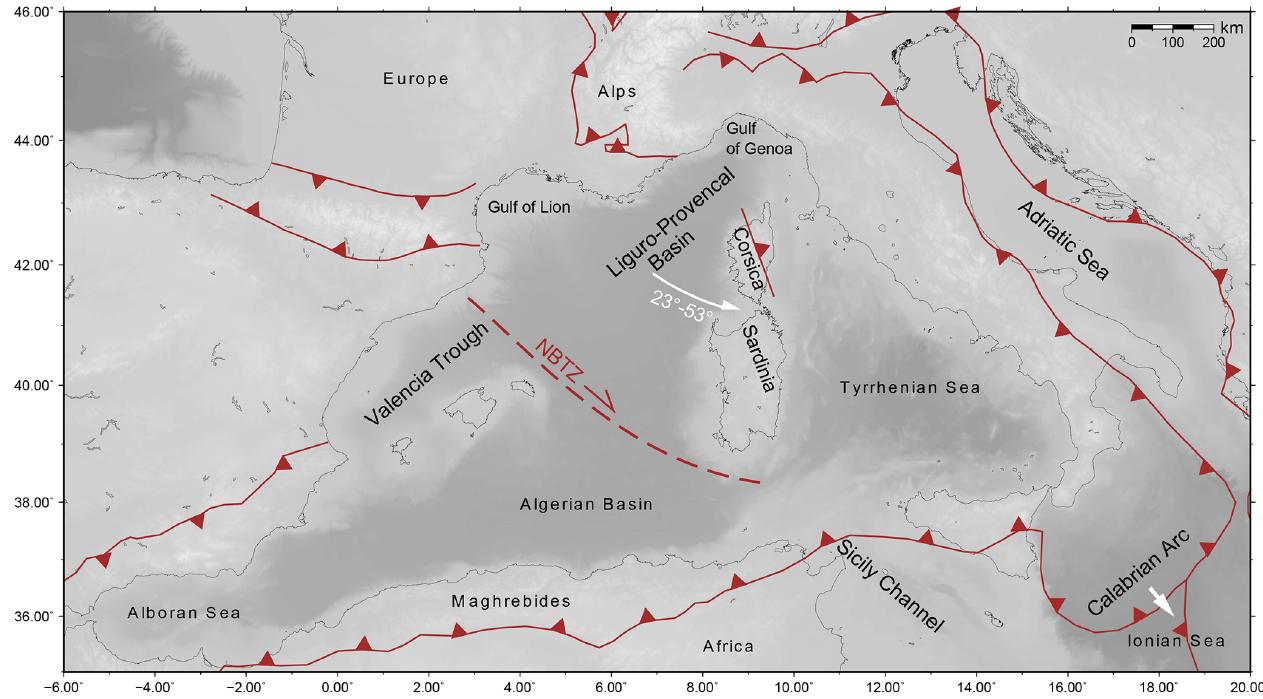
Figure 2. Geographic and tectonic overview map with thrusts modified from Le Breton et al. (2020) and the North Balearic Transform Zone (NBTZ) (van Hinsbergen et al., 2014). The white arrows indicate the ∼ 23 to 45 ◦ CCW rotation of the Corsica–Sardinia block during Miocene times (Speranza et al., 2002; Gattacceca et al., 2007) and the ∼ 53 ◦ during Oligocene–Miocene times (Le Breton et al., 2017) and the trench retreat of the Calabrian Arc. GMRT data were used as background topography (Ryan et al.,